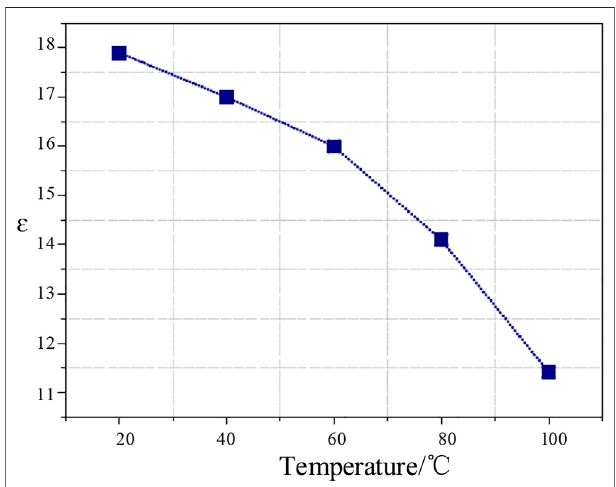
FIGURE 8 | Correction coef fi cient ε temperature in fl uence